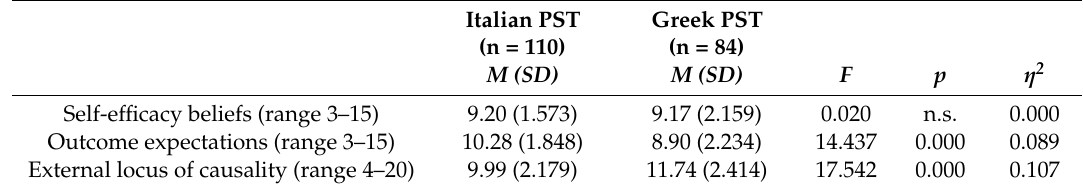
Table 1. Self Confidence in dealing with problems at school. Comparison between Italian and Greek PST (one-way